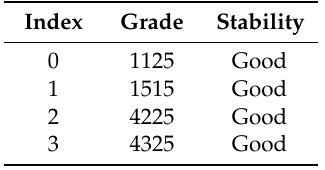
Table 8. Indexed list for good stability.